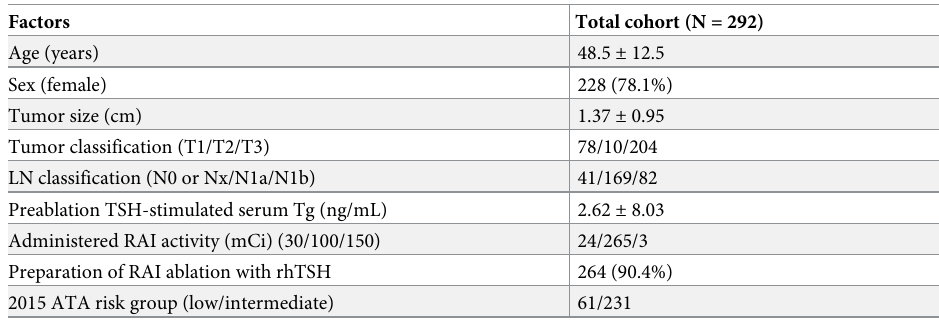
Table 1. Patient